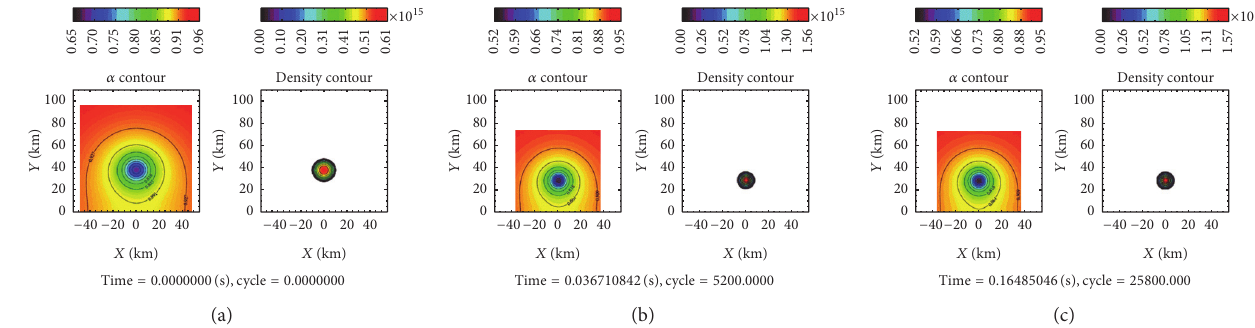
Figure 5: Contours of the lapse function (left) and central density (right) at cycle numbers 0 (a), 5,200 (b), and 25,800 (c) corresponding to roughly 0, 5, and 19 orbits.